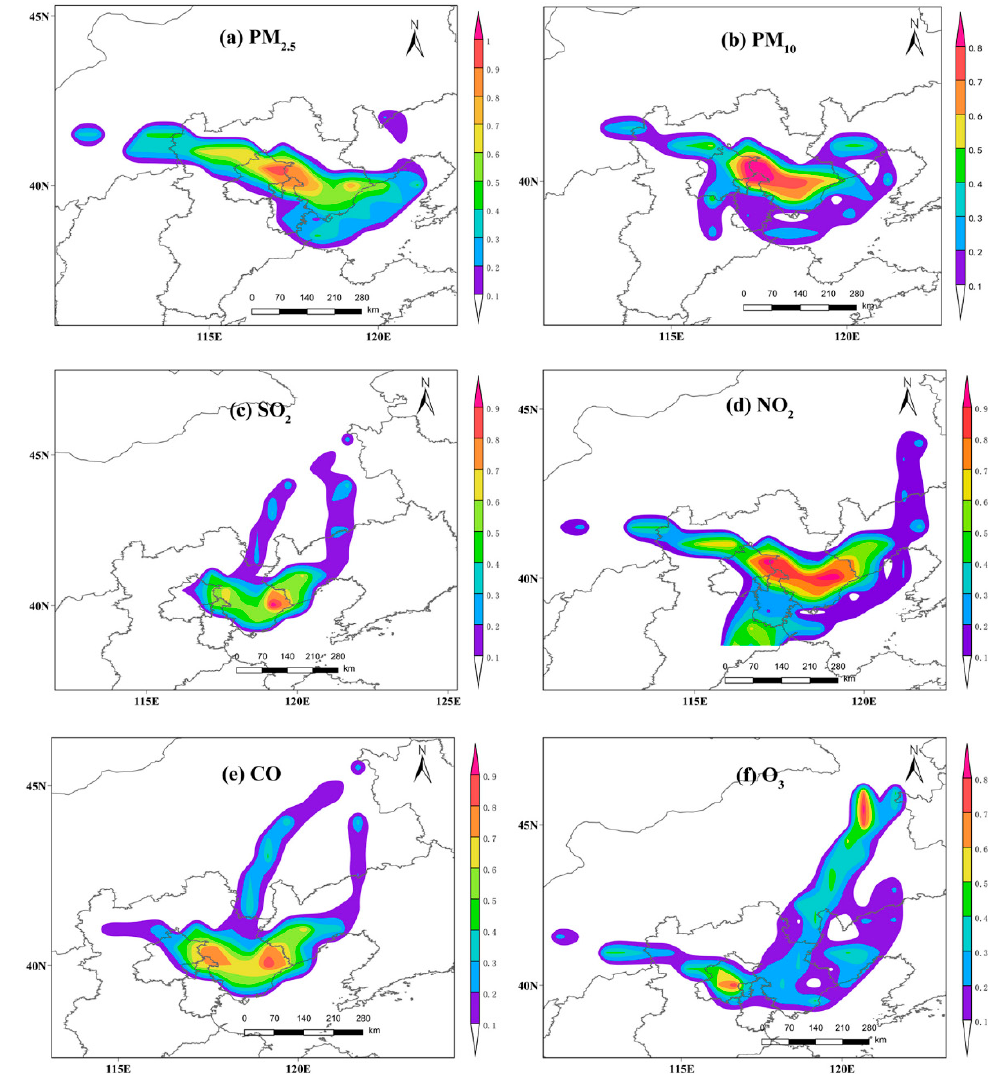
Figure 8. Analysis of potential areas acting as sources of atmospheric pollutants during the Spring Festival in 2020.